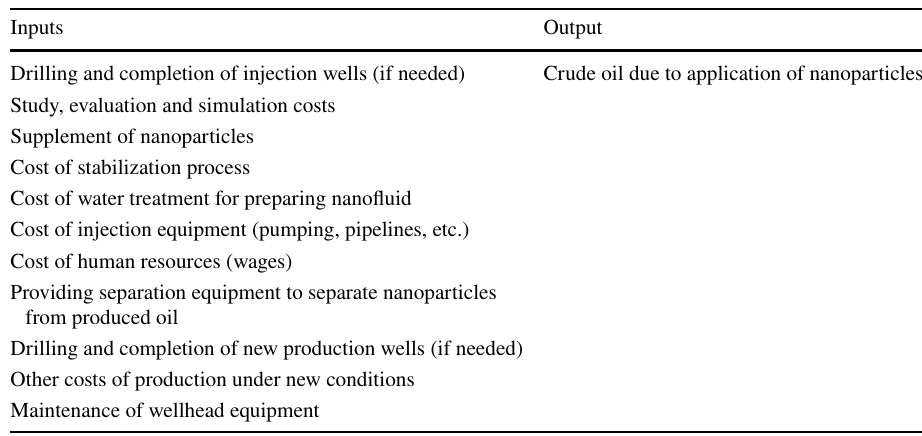
Table 6 Revenues (outputs) and costs (inputs) which should added to the